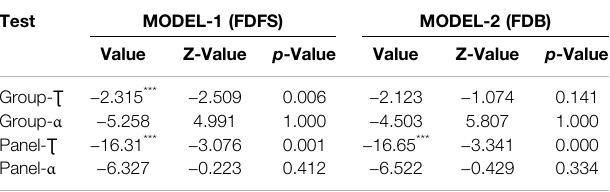
TABLE 4 | Results of Westerlund panel co-integration test.